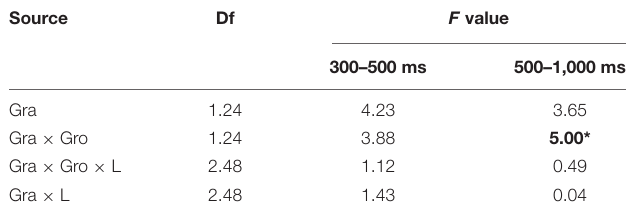
TABLE 4 | Summary of global ANOVA for the two